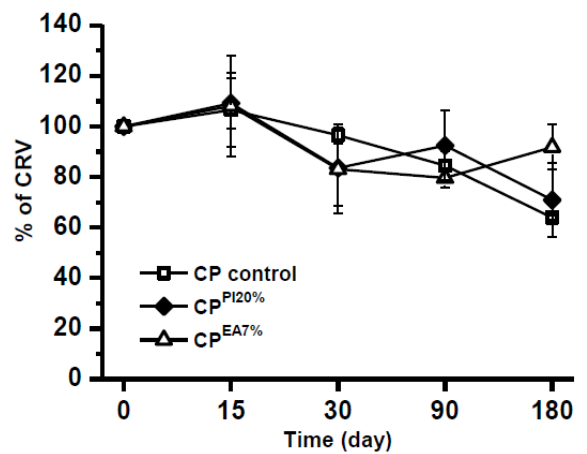
Figure 5. Results shown for CRV decay in different CPs stored at room temperature for up to 180 days.